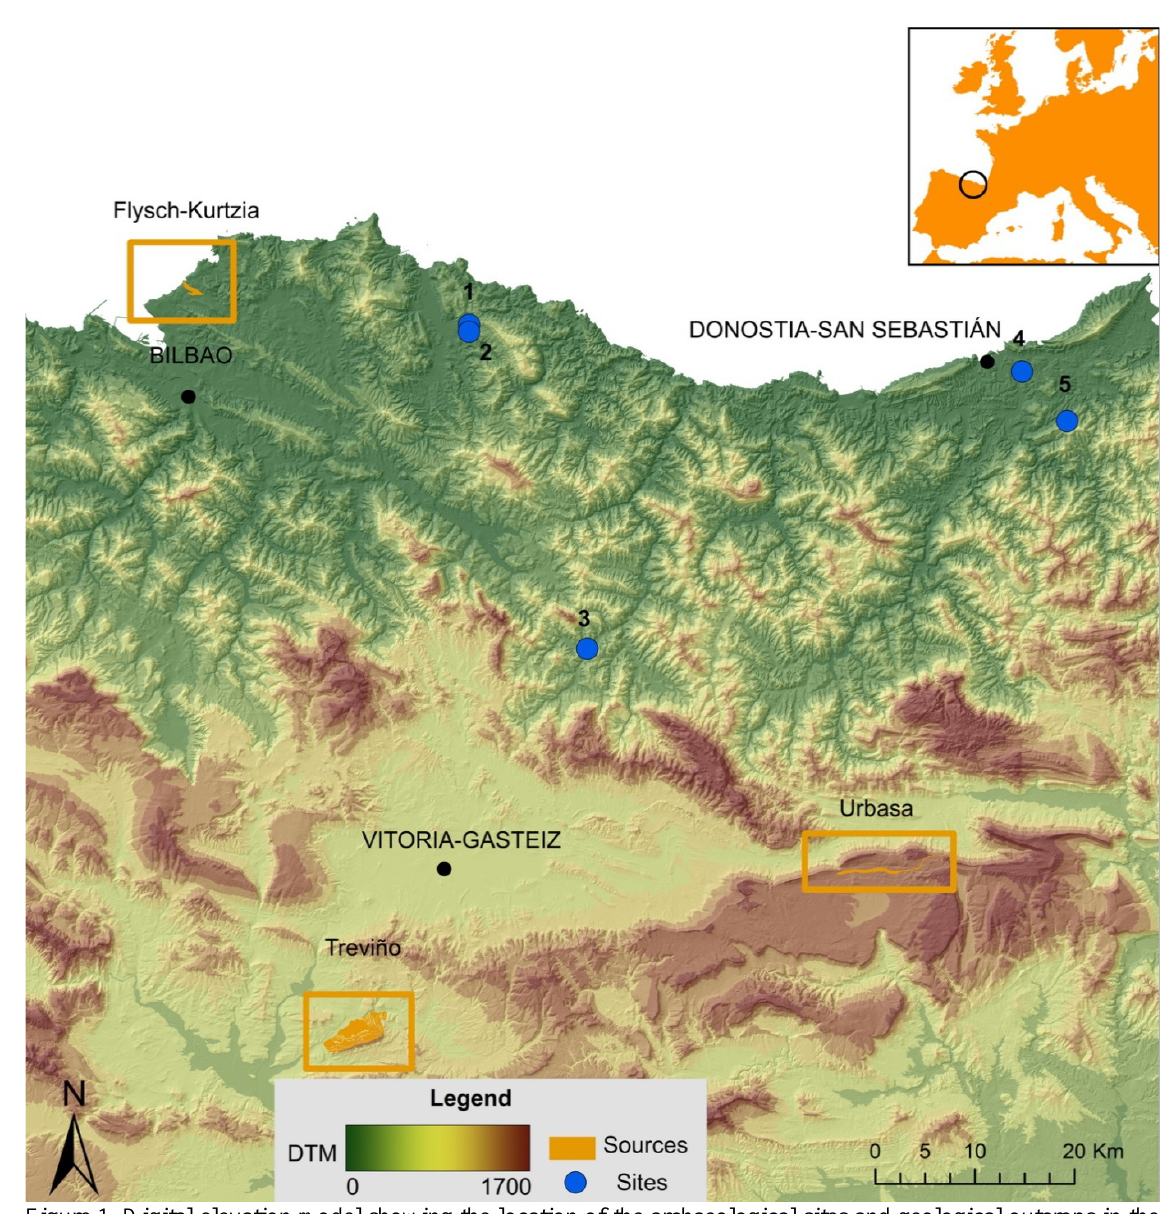
Figure 1. Digital elevation model showing the location of the archaeological sites and geological outcrops in the area of study. Archaeological sites: 1. Antoliñako Koba, 2. Santimamiñe, 3. Labeko Koba, 4. Ametzagaina